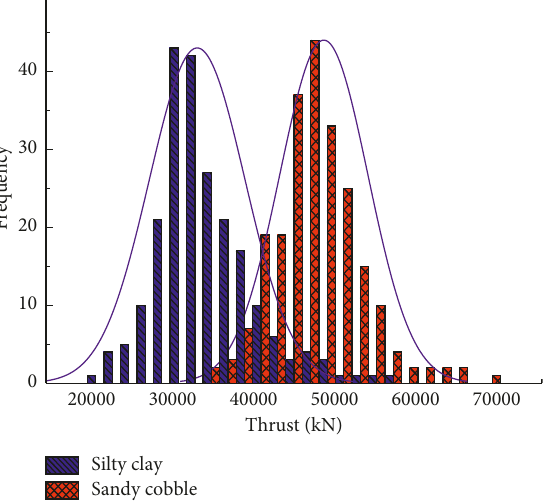
Figure 9: Bar distribution of shield